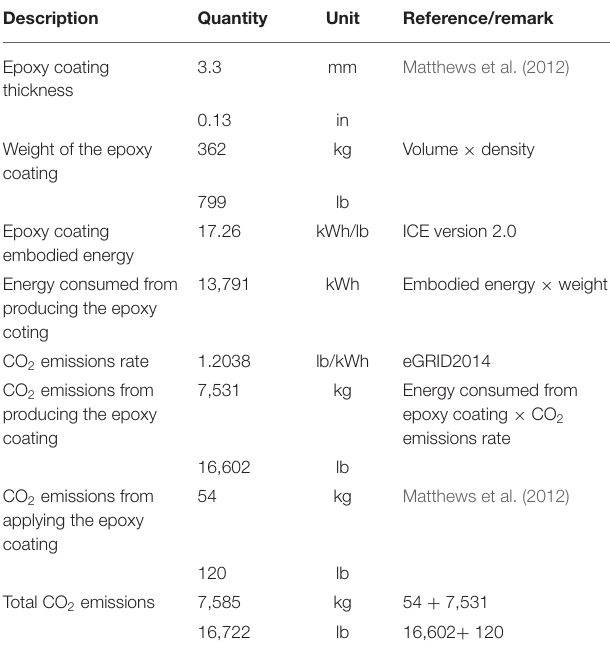
TABLE 6 | Carbon emissions during the cleaning of PCCP pipe after the epoxy coating is used.